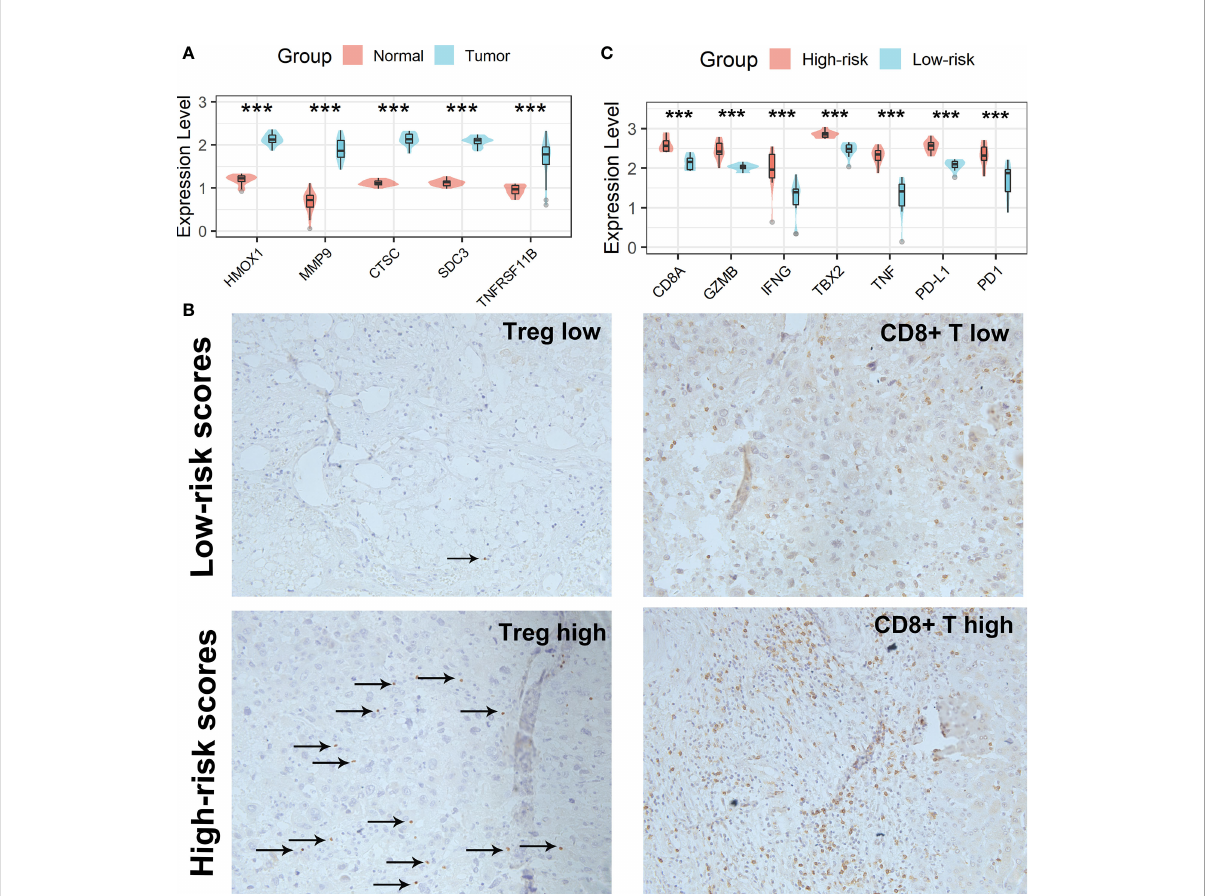
FIGURE 10 Veri fi cation of the Tregs-related signature in clinical samples. (A) All fi ve Tregs-related genes revealed differential expression between normal and tumor tissues. (B) Patients in the high-risk scores group had a higher abundance of Tregs and CD8 + T cells in fi ltration. (C) Differential analysis of in fl ammation/immune response-related genes. ***p <